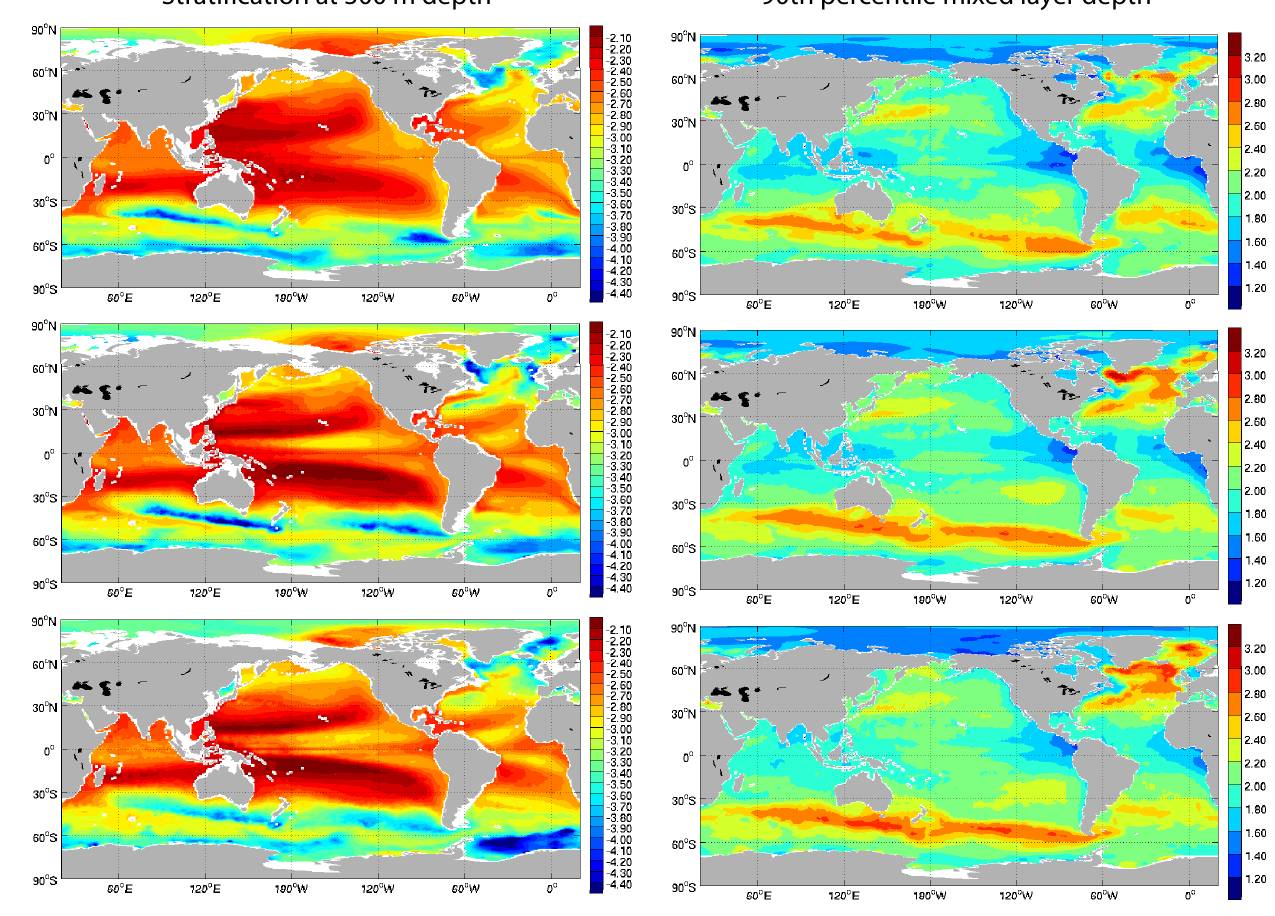
) in kgm − 4 ) and (right) 90th percentile mixed layer depth (shown Figure 6. (Left) median stratification at 300m depth (shown as log 10 ( ∂ρ ∂z as log 10 ( mld ) in m) for (bottom) in situ profiles, (middle) the corresponding state estimate profiles, and (top) model profiles generated by resetting K gm , K σ , and K d to the K gm , K σ , and K d first guess while retaining all other settings of the state estimate. Percentiles are computed from the distribution of individual profile values within grid boxes and